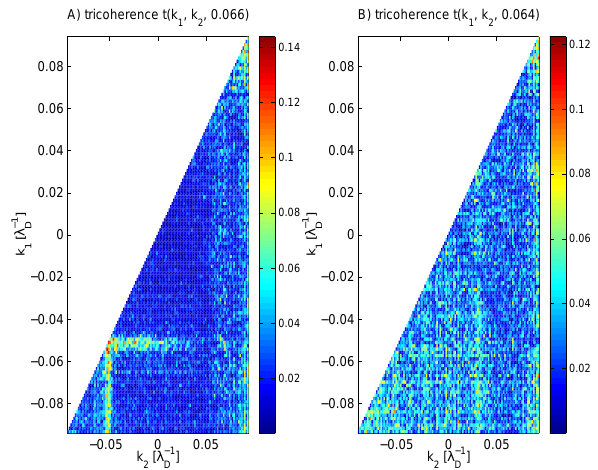
Fig. 6. The auto-tricoherence t EEEE (k 1 ,k 2 ,k 3 ) . Left panel shows the tricoherence computed for a fixed value of k 3 = 0 . 066 λ D , corresponding to the strongest Langmuir mode in the spectrum. The above threshold values indicate the presence of four-wave + l k → l + phase coupling corresponding to process l k 0 . 066 1 2 l (k . In the right panel the tricoherence for fixed k 3 = 1 + k 2 − 0 . 066 ) 0 . 064 λ D is depicted (a wave mode not included in the cascade). The tricoherence plot shows no significant features and contains only random